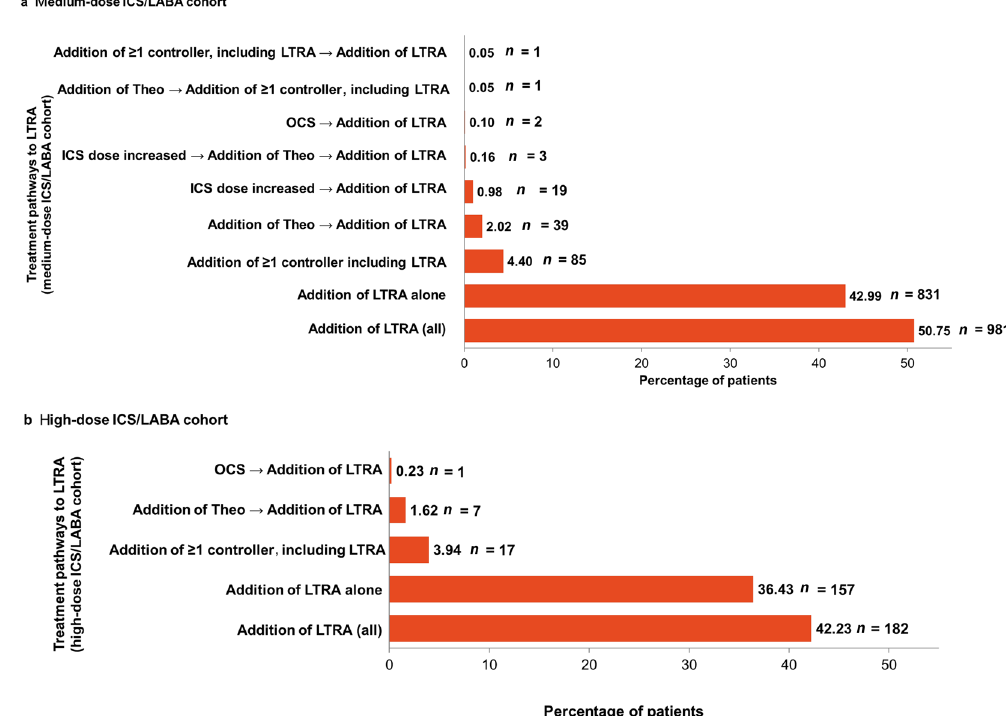
Fig. 2 Treatment pathways to LTRA after the fi rst episode of uncontrolled asthma in medium- and high-dose ICS/LABA cohorts. a Medium-dose ICS/LABA cohort; total number of patients with uncontrolled asthma and at least 365 days of follow-up, 1933; b high-dose ICS/LABA cohort; total number of patients with uncontrolled asthma and at least 365 days of follow-up, 431. n patients with treatment pathways to LTRA, ICS inhaled corticosteroid, LABA long-acting β 2 -agonist, LTRA leukotriene receptor antagonist, OCS oral corticosteroid, Theo